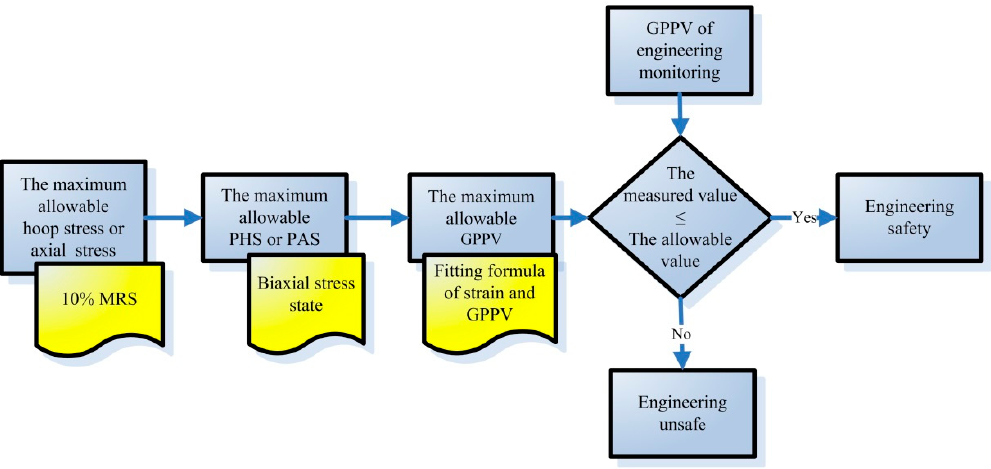
Figure 20. Flow chart of engineering blasting safety monitoring. Figure20. Flow chart of engineering blasting safety monitoring. Figure20. Flow chart of engineering blasting safety monitoring.